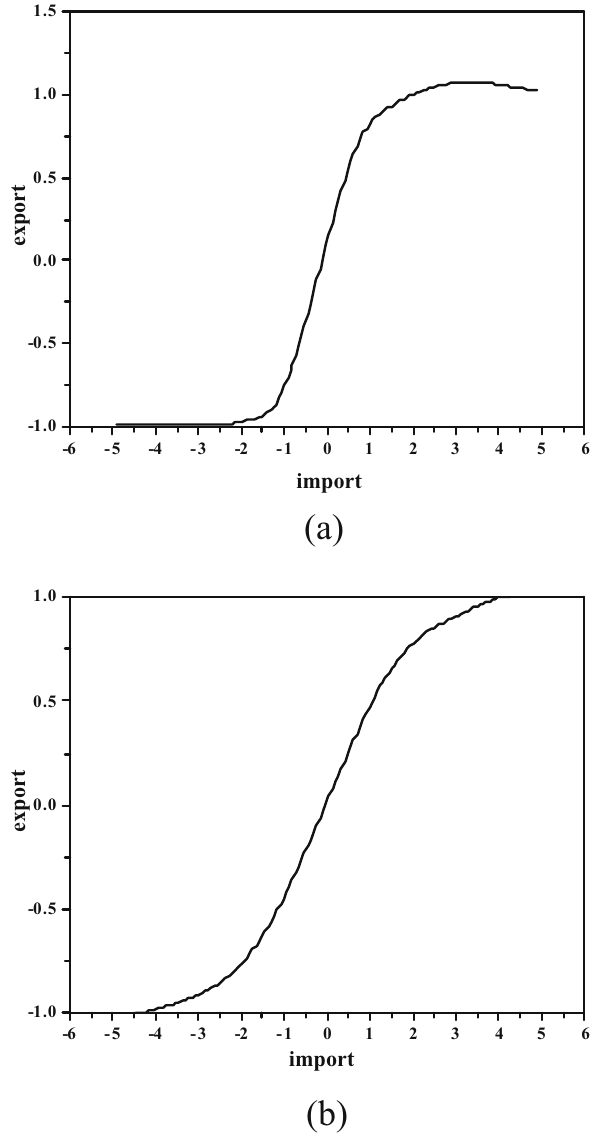
Figure 2: Curve distribution diagram of the tangent function ( a ) and logarithmic function ( b )